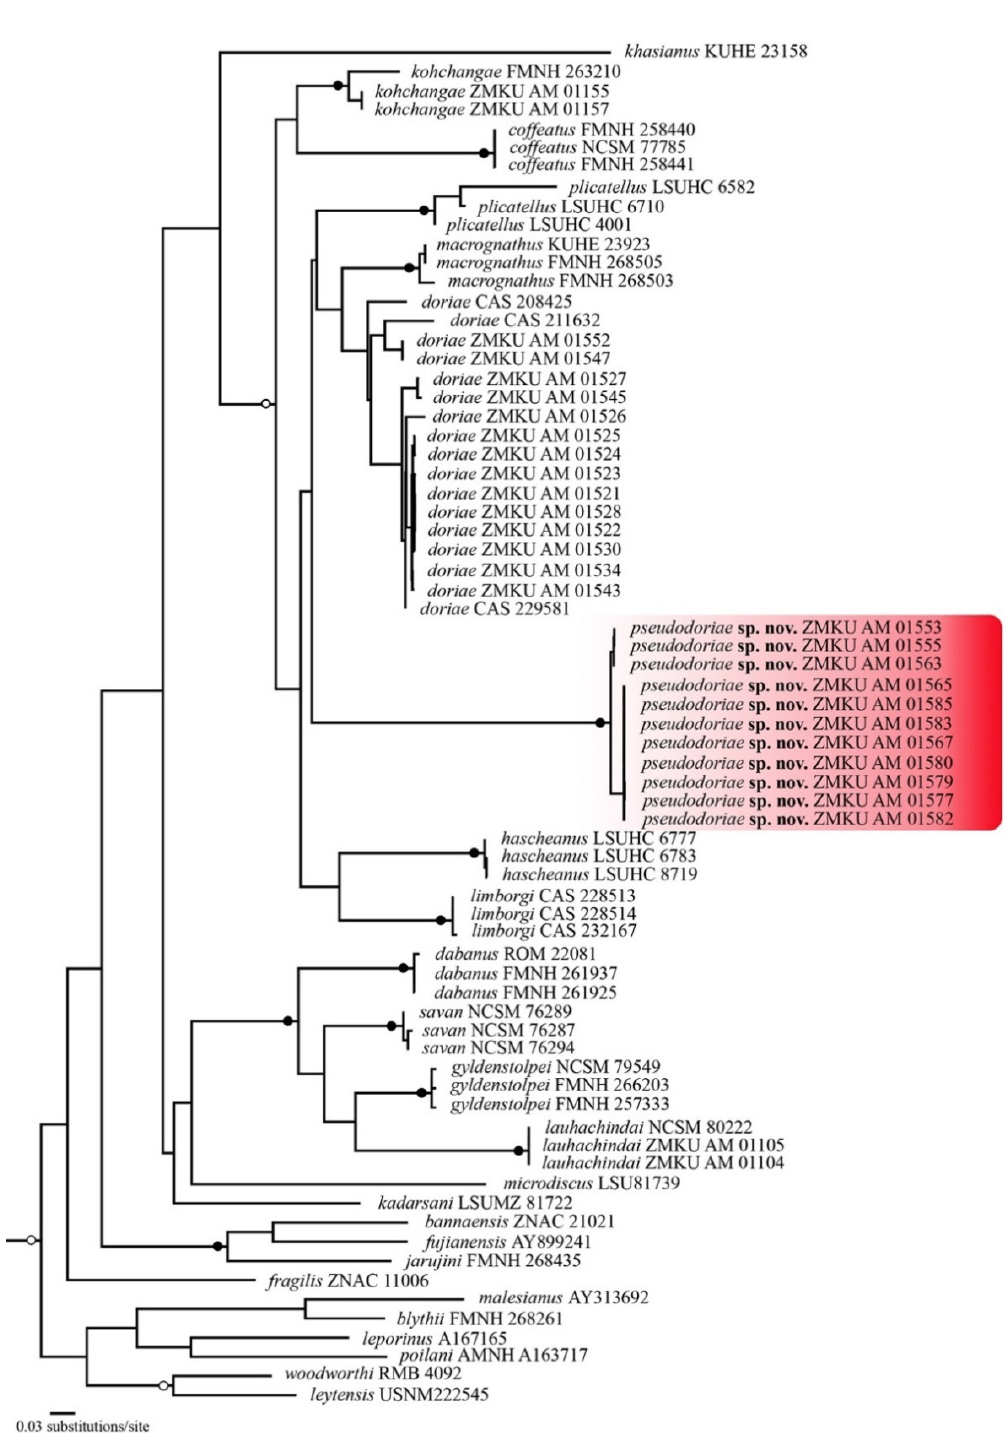
Figure 2. The best tree resulting from maximum likelihood analysis of 2380 aligned characters of mitochondrial DNA from dicroglossid frogs in the genus Limnonectes . The outgroups Fejervarya limnocharis (NC_005055) and Quasipaa spinosa (NC_013270) were included in the analysis (not shown). Black circles at nodes indicate bootstrap values ≥ 0.99, and open circle at nodes indicate boostrap values ≥ 0.95. Numbers at terminal tips are voucher numbers (except those for L. fujianensis and L. malesianus are GenBank accession numbers). GenBank accession numbers and locality data for sequenced samples are provided in Table S1.